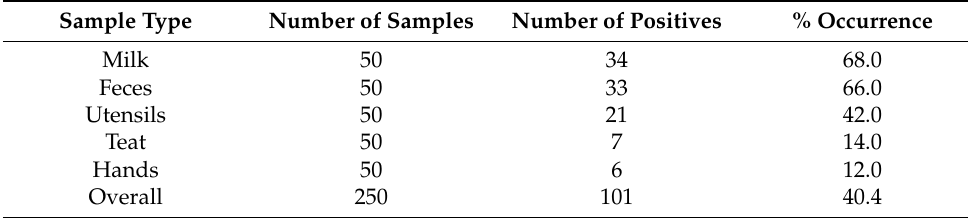
Table 1. Occurrence of E. coli in raw cow’s milk and related samples.